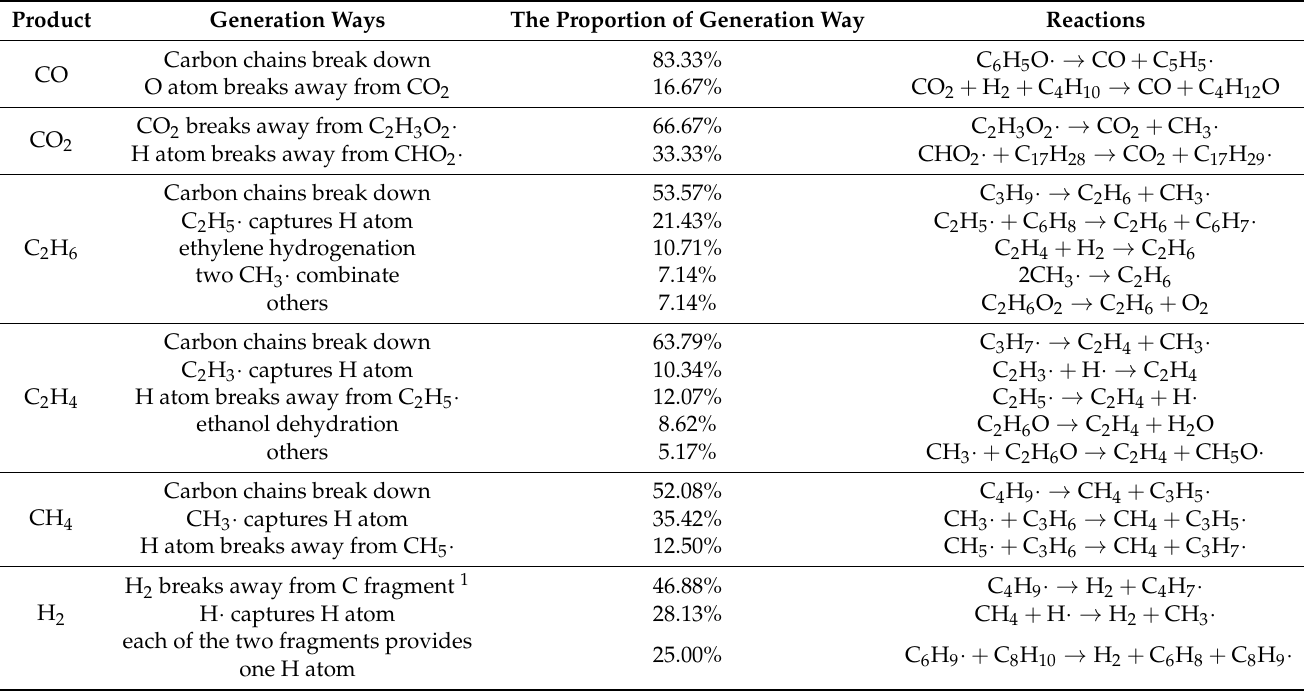
Table 1. The formation methods of six typical small